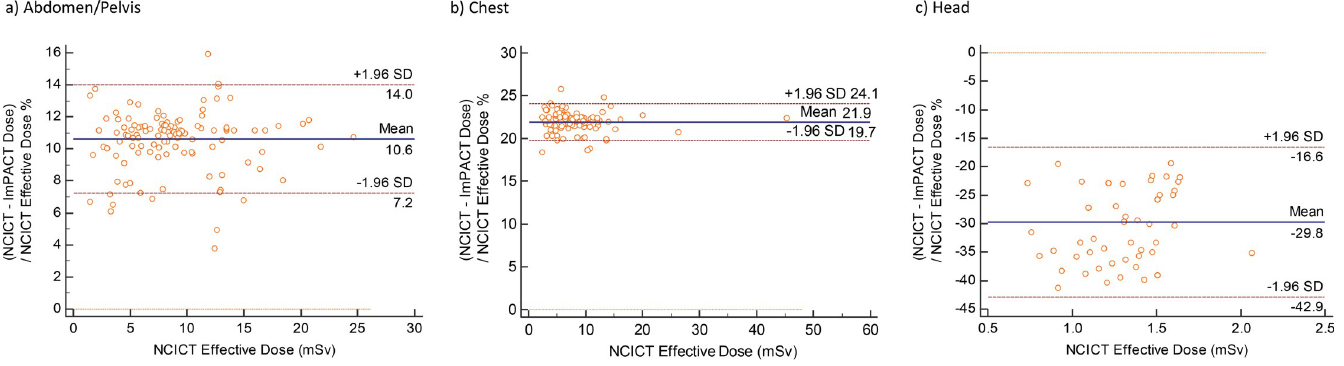
Fig 2. Bland Altman Plots for effective dose for the a) abdomen/pelvis b) chest and c) head